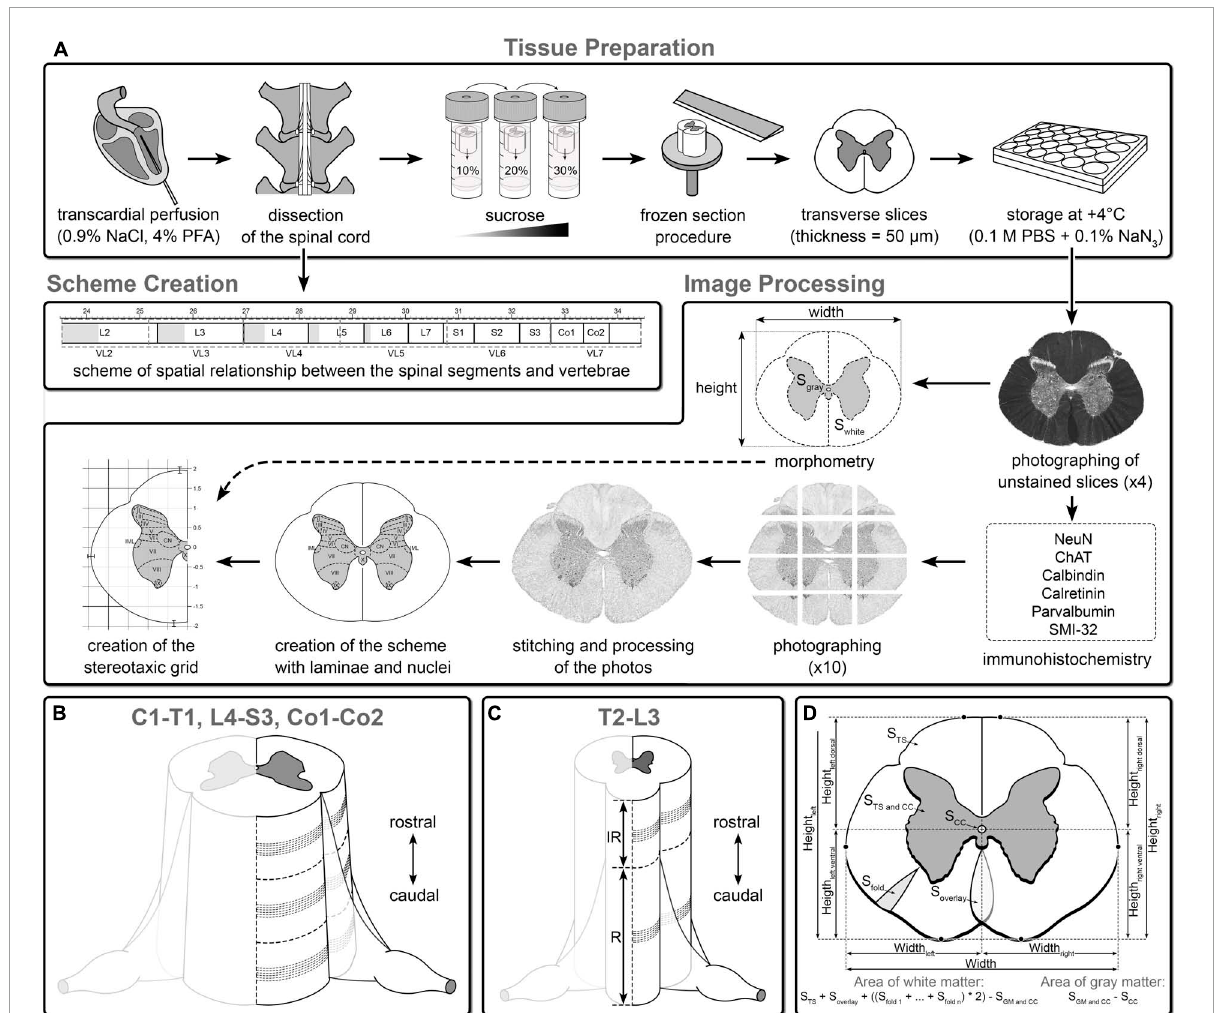
FIGURE1 Overview of the steps of atlas creation. (A) Tissue preparation and image processing (see details in Section “Materials and methods”). Algorithm for selection of the slices for the atlas on the example segments L4 (B) and T13 (C) segments: IR, interrootlet part of the segment; R, rootlet part of the segment, dashed loci correspond to area from which slices were taken into immunohistochemical study. (D) Morphometry of the spinal cord. S TS, area of transverse slice of the segment; S GM and CC, area of gray matter and central canal; S CC, area of central canal; S fold, area of white matter fold; S overlay, area of superimposed zones of white matter; Height left, height of left half of the segment; Height right, height of right half of the segment; Height left dorsal, distance from the central canal to the highest point in the left dorsal quarter of the segment; Height left ventral, distance from the central canal to the highest point in the left ventral quarter of the segment; Height right dorsal, distance from the central canal to the highest point in the right dorsal quarter of the segment; Height right ventral, distance from the central canal to the highest point in the right ventral quarter of the segment; Width, width of the segment; Width left, distance from the central canal to the most lateral point of the left half of the segment; Width right, distance from the central canal to the most lateral point of the right half of the